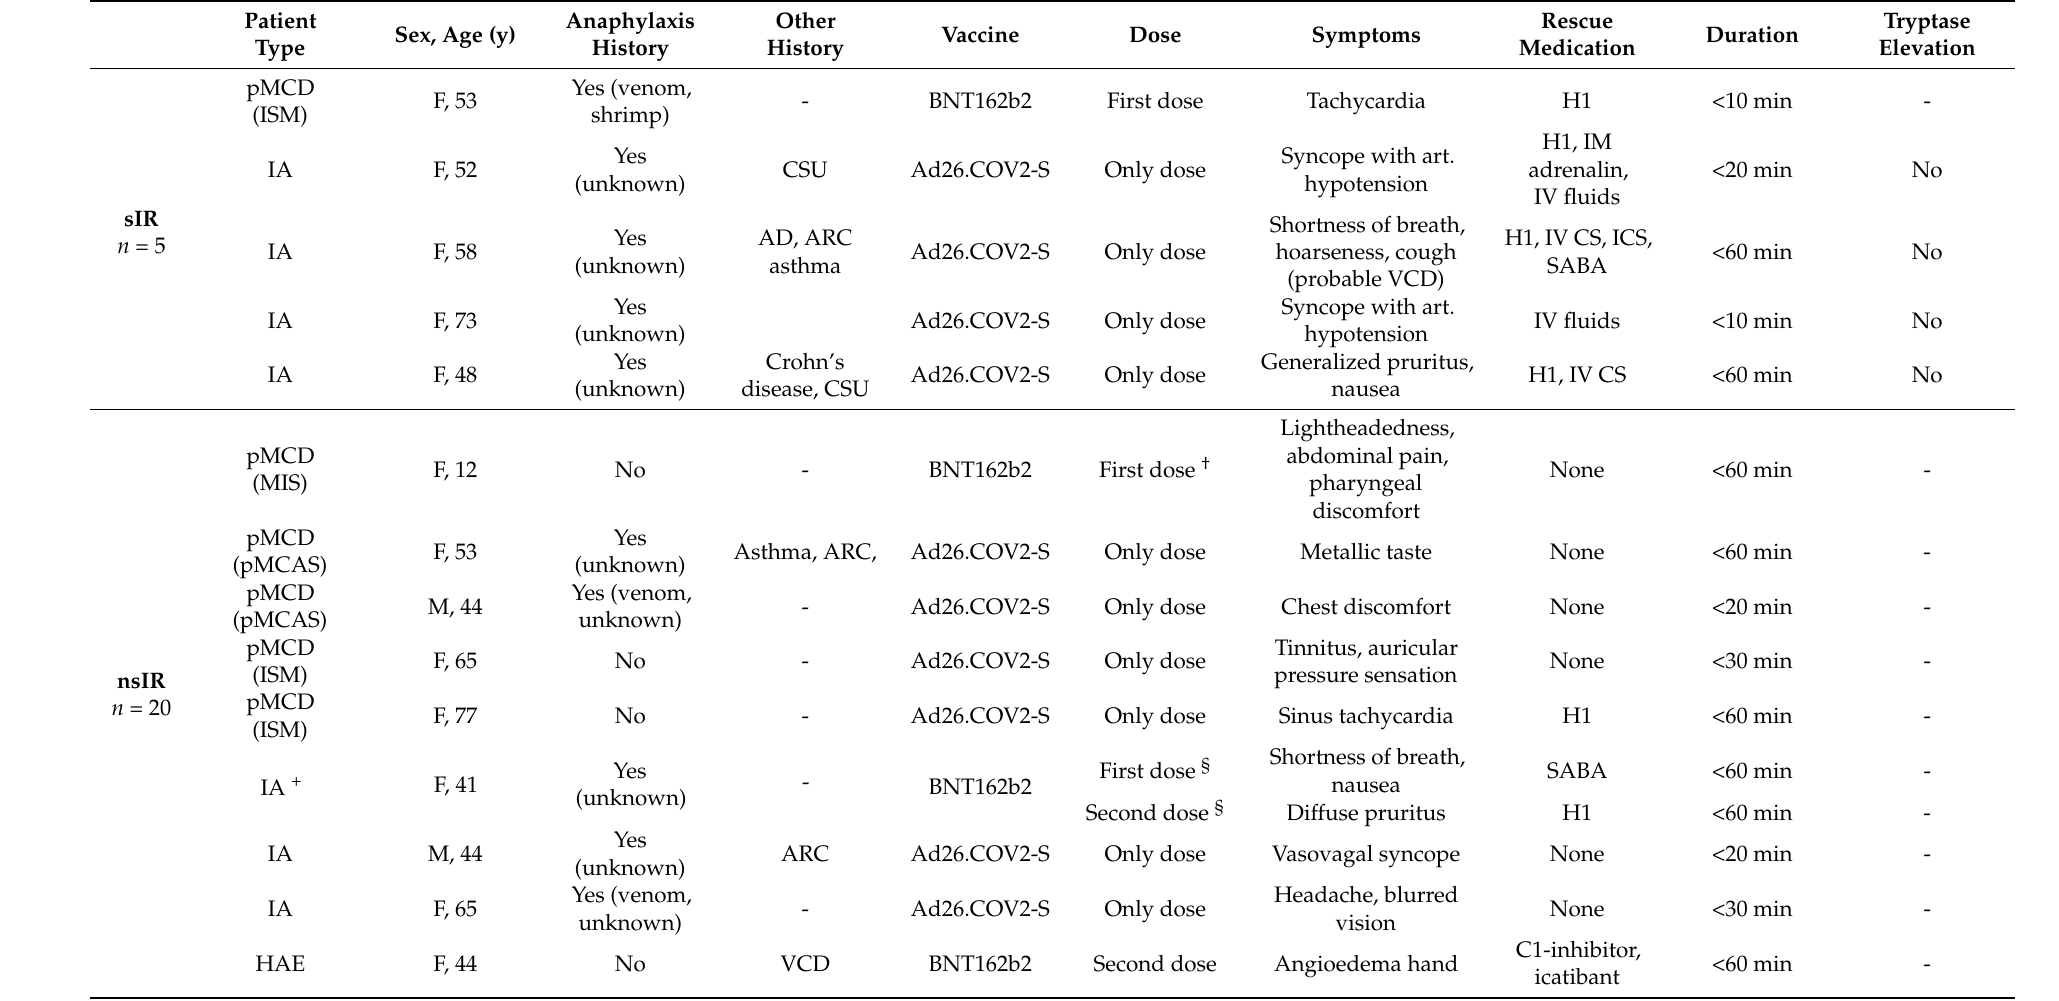
Table 3. Immediate